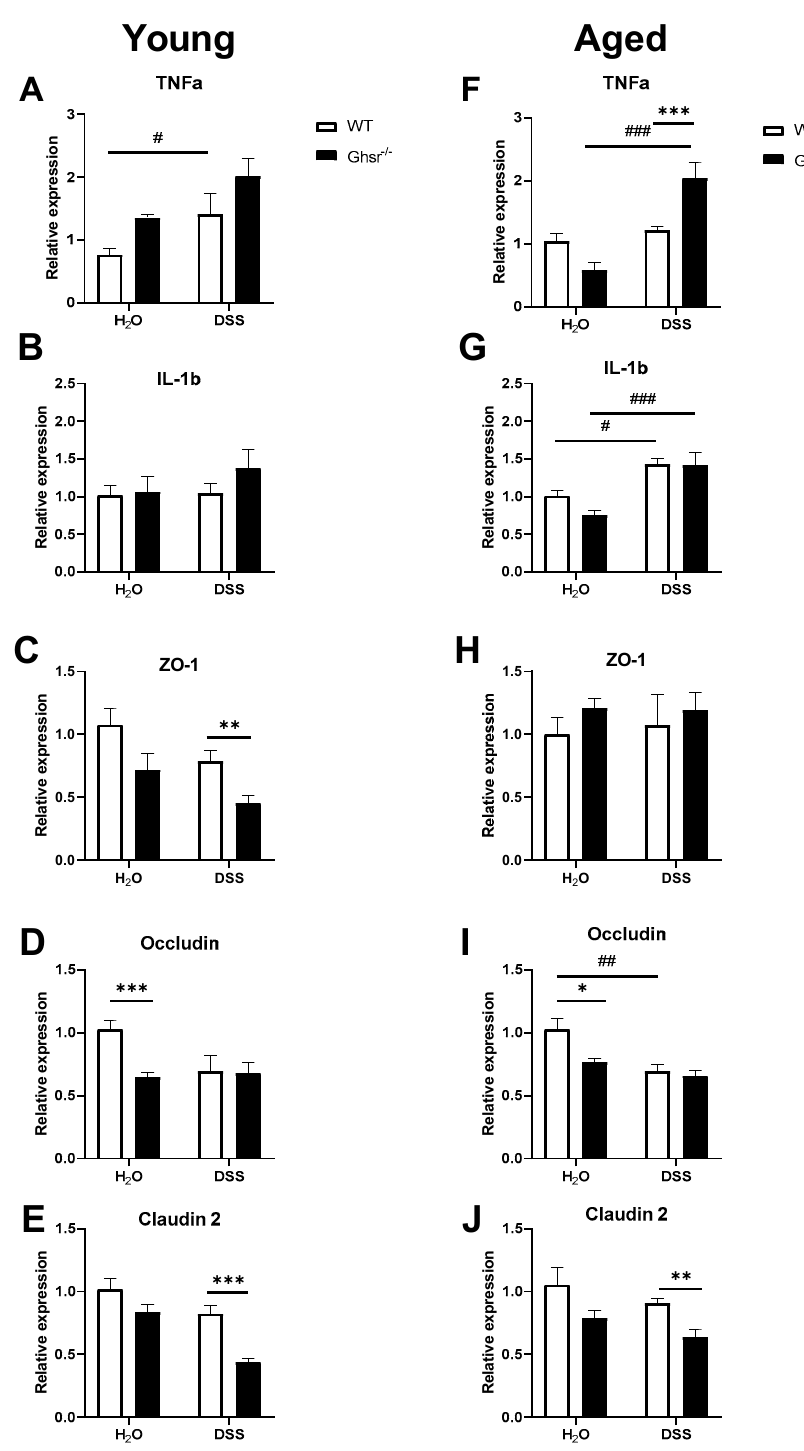
Figure 4. Young and aged Ghsr − / − showed elevated pro-inflammatory cytokines and worsened gut permeability gene expression in colon. Young (4–6-month-old) or aged (18-month-old) male mice were exposed to 2% ( w / v ) DSS for 7 consecutive days. The left panels are from the young group and the right panels are from the old group. Expression of proinflammatory cytokines, ( A , F ) TNF α and ( B , G ) IL-1b in colon mucosa. Gene expression of tight junction markers: ( C , H ) ZO-1 , ( D , I ) Occludin , and ( E , J ) Claudin 2 . n = 4–5. * p < 0.05, ** p < 0.01, *** p < 0.001, WT vs. Ghsr − / − ; #, p < 0.05, ##, p < 0.01, ### p < 0.001 DSS vs. control in each genotype.